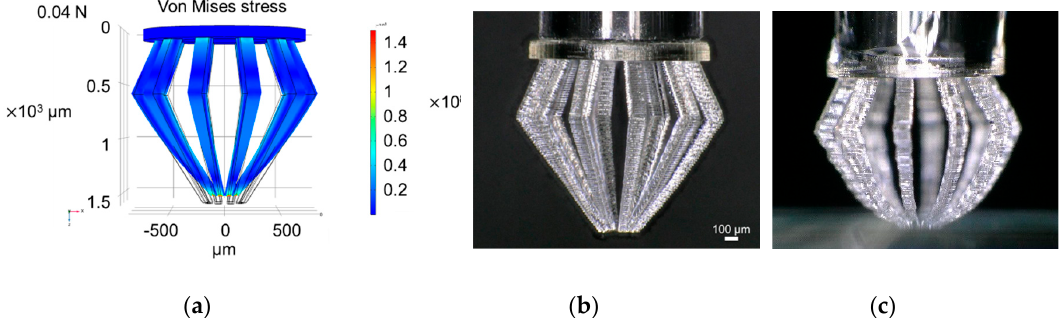
Figure 7. Bending of the microfinger on the substrate: ( a ) Simulation results under a load of 0.04 N; ( b , c ) demonstration of microfingers mounted on a glass capillary before and after pressing them on the substrate.